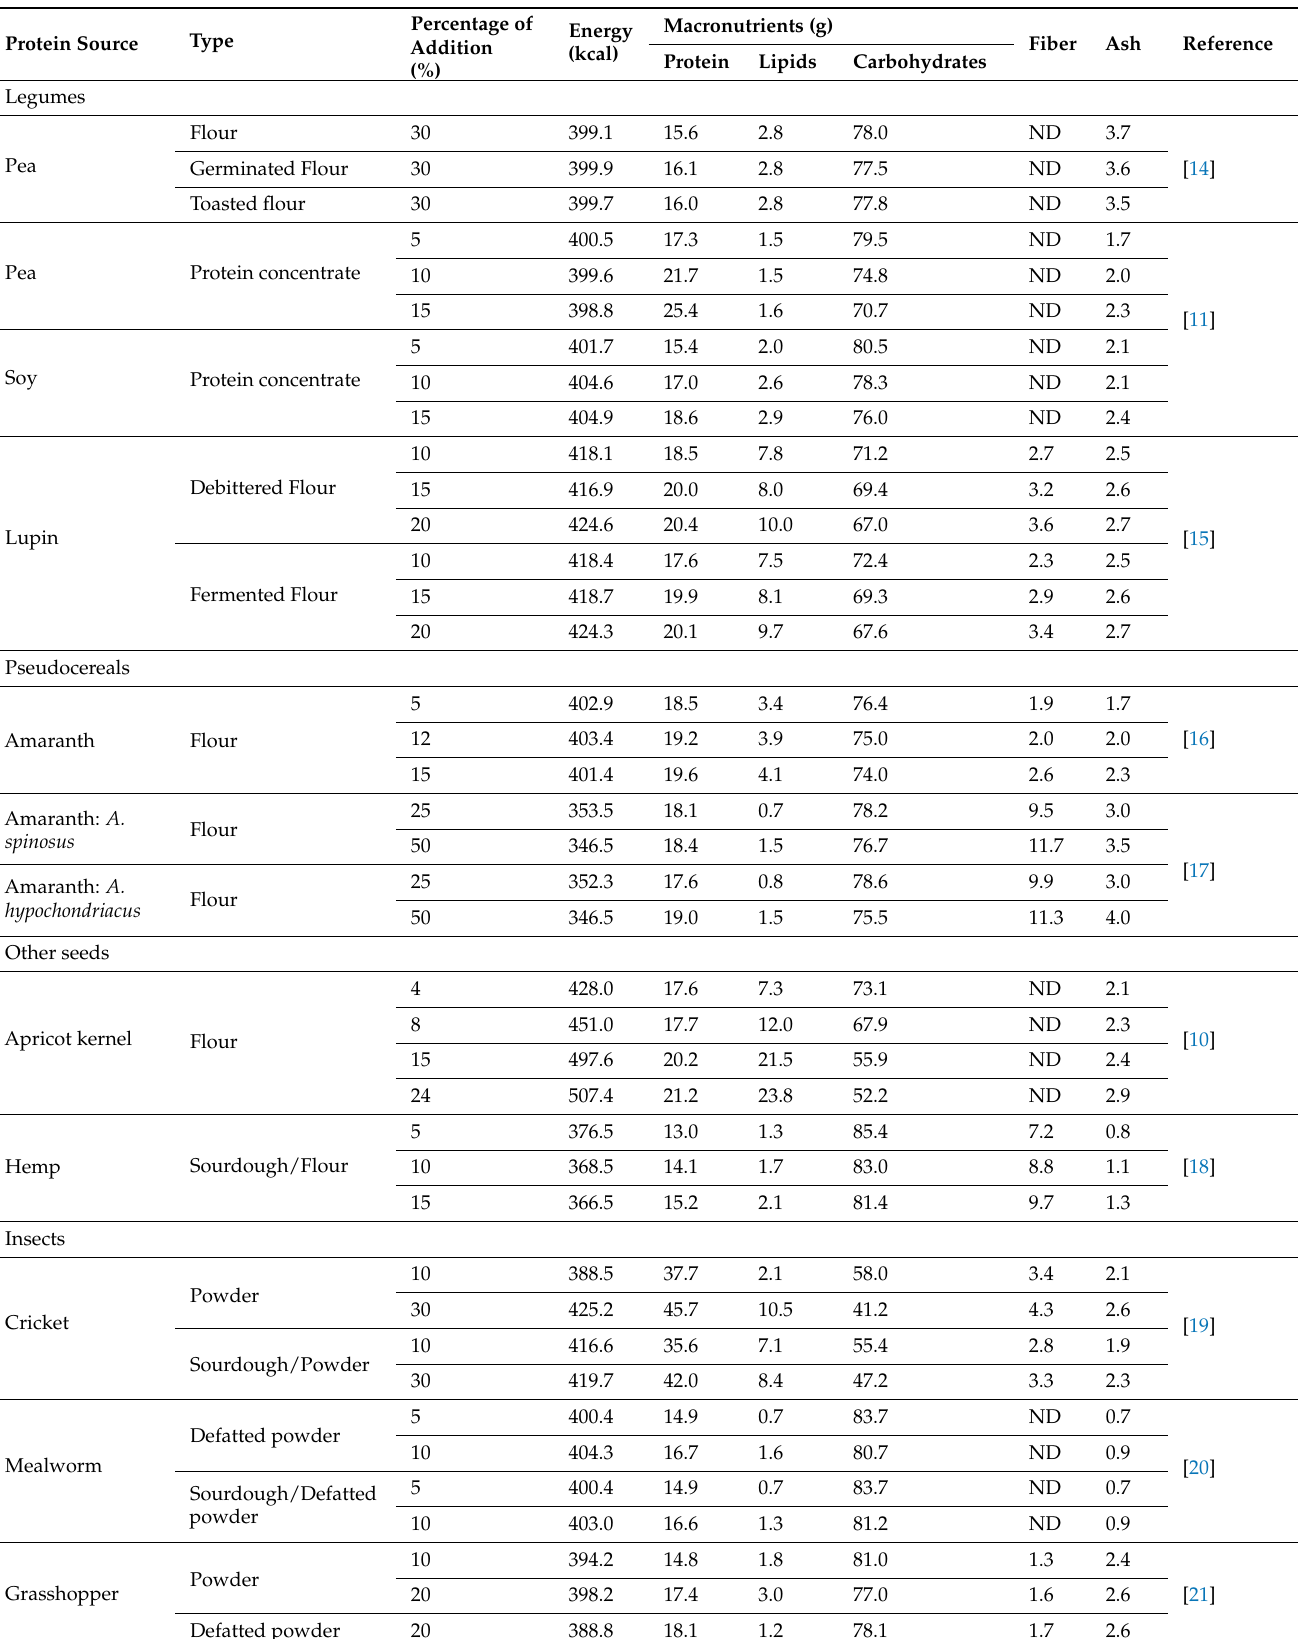
Table 1. Nutritional content in 100 g of bread (dry